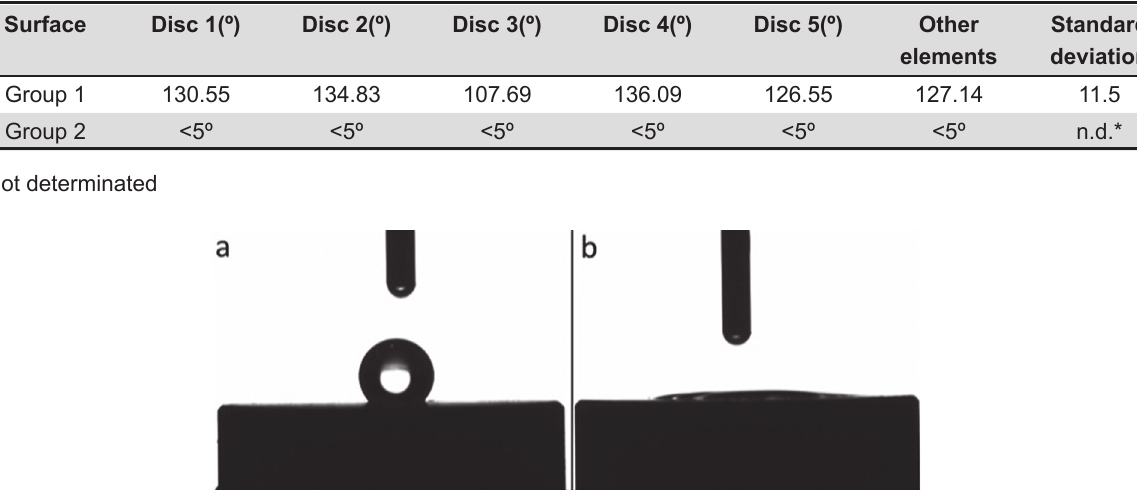
Figure 3- Contact angle of Group 1 (a) and Group 2 (b). It is possible see that a drop of simulated body fluid (SBF) solution had been deposited onto sample surfaces. Note that the angle formed between solution drop and Group 2 surface was smaller than